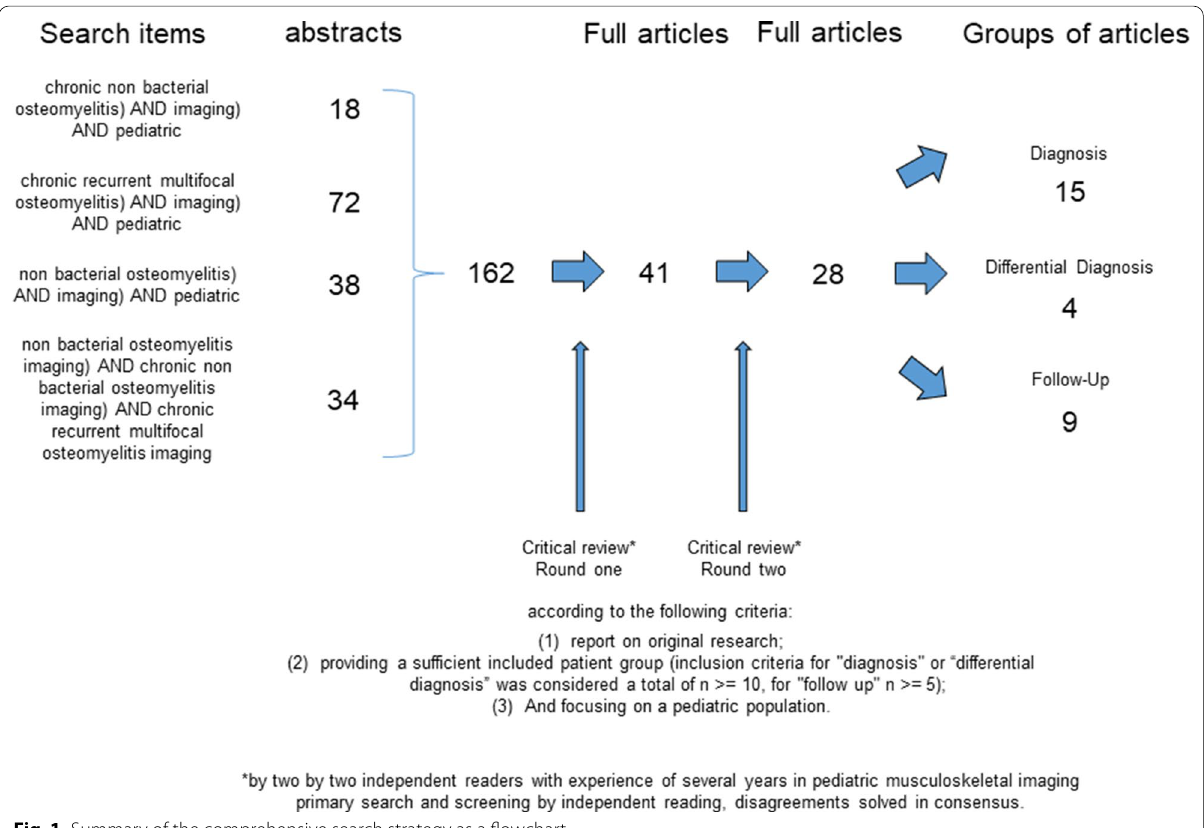
Fig. 1 Summary of the comprehensive search strategy as a